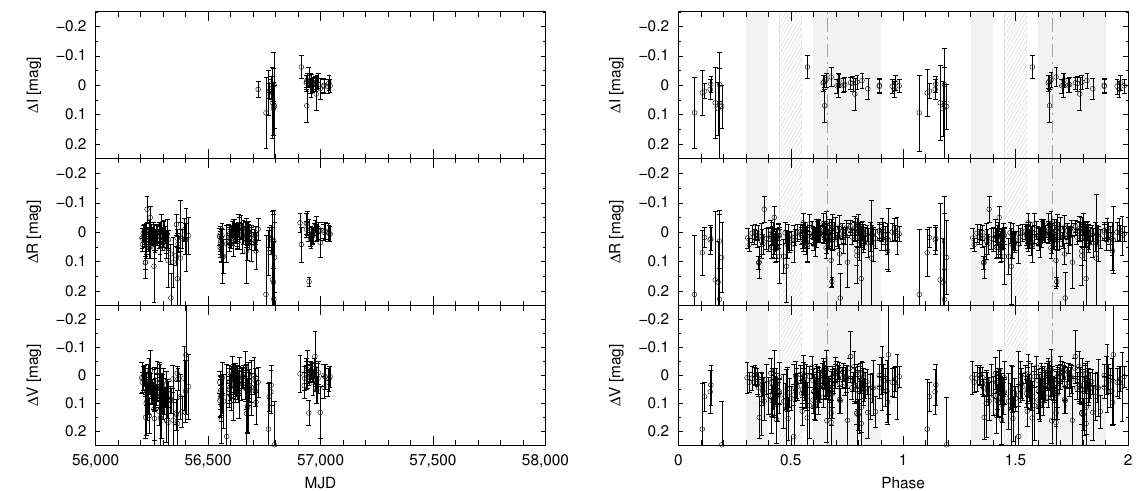
Figure 8. The same as Figure 2, but for HESS J0632 + 057 by Kanata/HOWPol. See Figure 5 for the description of the gray and striped